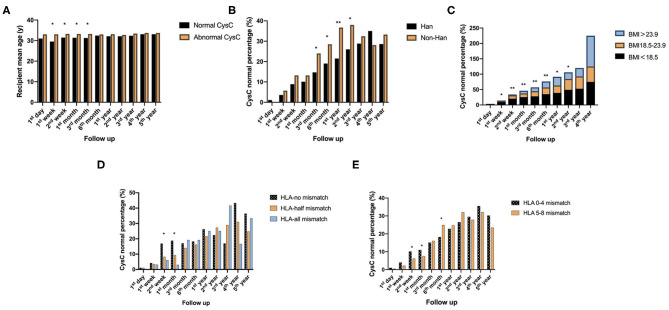
Recipient-related factors of short-term impact on postoperative kidney function reflected by CysC value: (A) Comparison of the age of recipients with normal and abnormal CysC at different time points follow up after surgery. (B) Comparison of CysC normal percentage between Han and non-Han recipients at different time points follow up after surgery. (C) Comparison of CysC normal percentage between groups of different ranges of recipients' BMI at different time points follow up after surgery. (D,E) are comparison of CysC normal percentage between different numbers of HLA loci mismatch at different time points follow up after surgery (*P < 0.05; **P < 0.001).